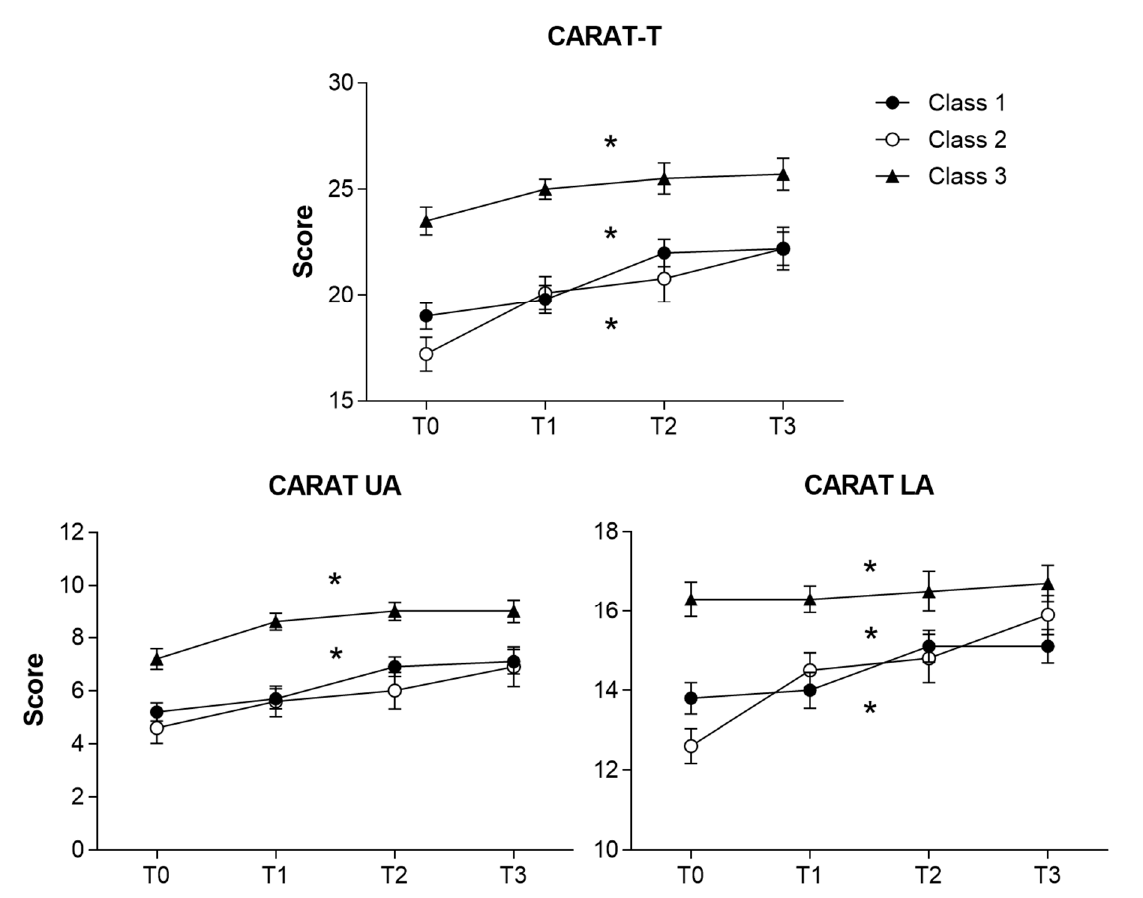
Figure 1. Longitudinal changes in the three CARAT scores (T, UA, and LA), in classes 1 ( n = 89), class 2 ( n = 31) and class 3 ( n = 43). Error bars indicating standard error of the mean. CARAT: Control of Allergic Rhinitis and Asthma Test; T0: baseline assessment; T: total; UA: Upper airways; LA: Lower airways. * significant overall longitudinal changes ( p < 0.05). T0: baseline assessment; T1: 1-week; T2: 1-month; T3: 4-month follow-up.